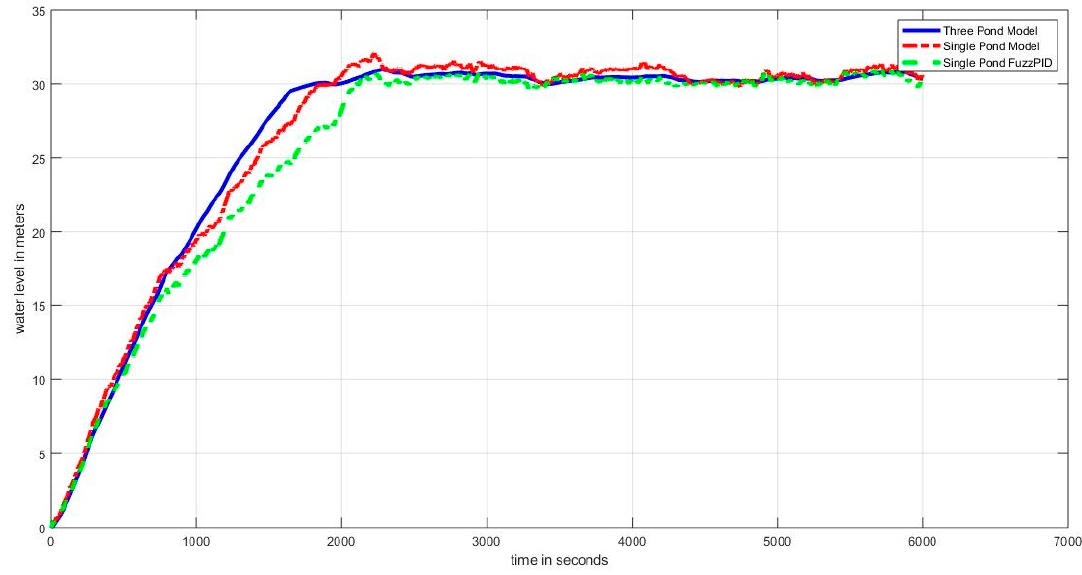
Figure 19. Three-Pond and Single-Pond (Fuzzy and FuzzyPID) systems (white noise disturbance).